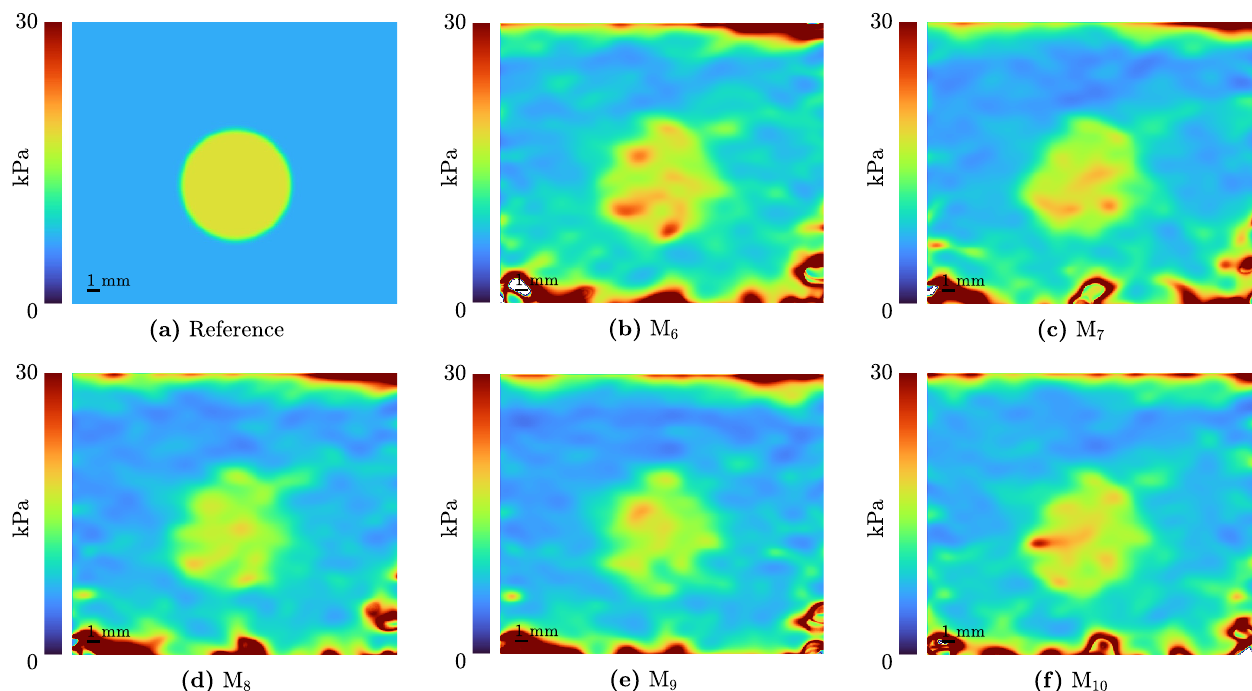
Figure 19. The results of the elastography algorithm of I 4 compared to the reference elastogram, which represents the mechanically measured Young’s modulus for the two mixtures.